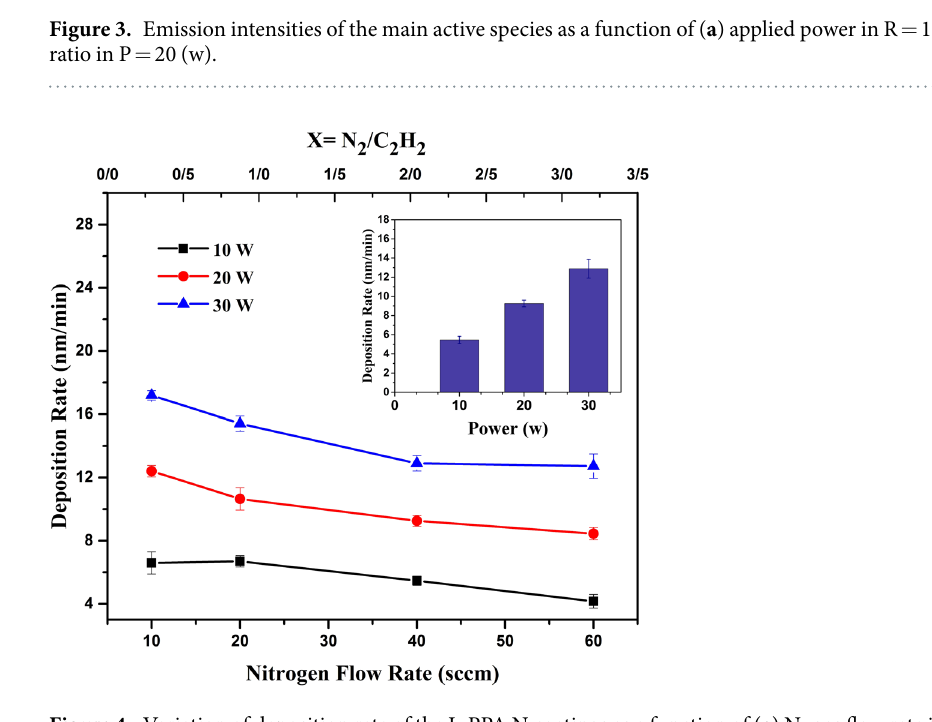
Figure 4. Variation of deposition rate of the L-PPA:N coatings as a function of ( a ) N 2 gas flow rate in different powers and ( b ) RF power in 40 sccm (C 2 H 2 flow rate: 20